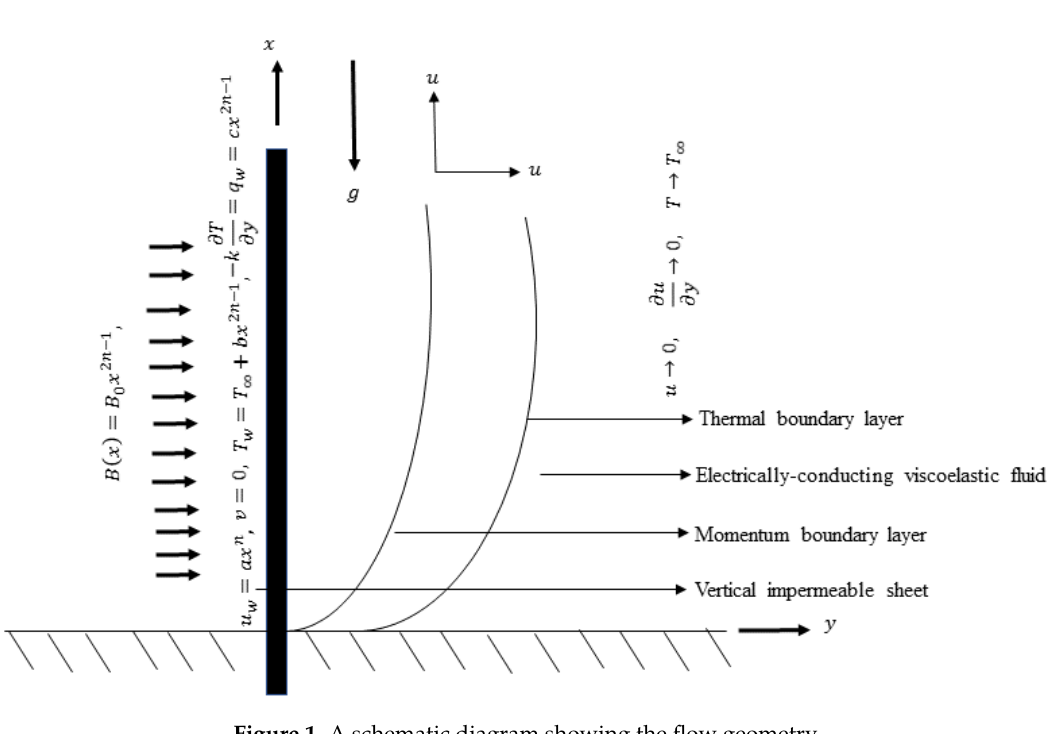
Figure 1. A schematic diagram showing the flow